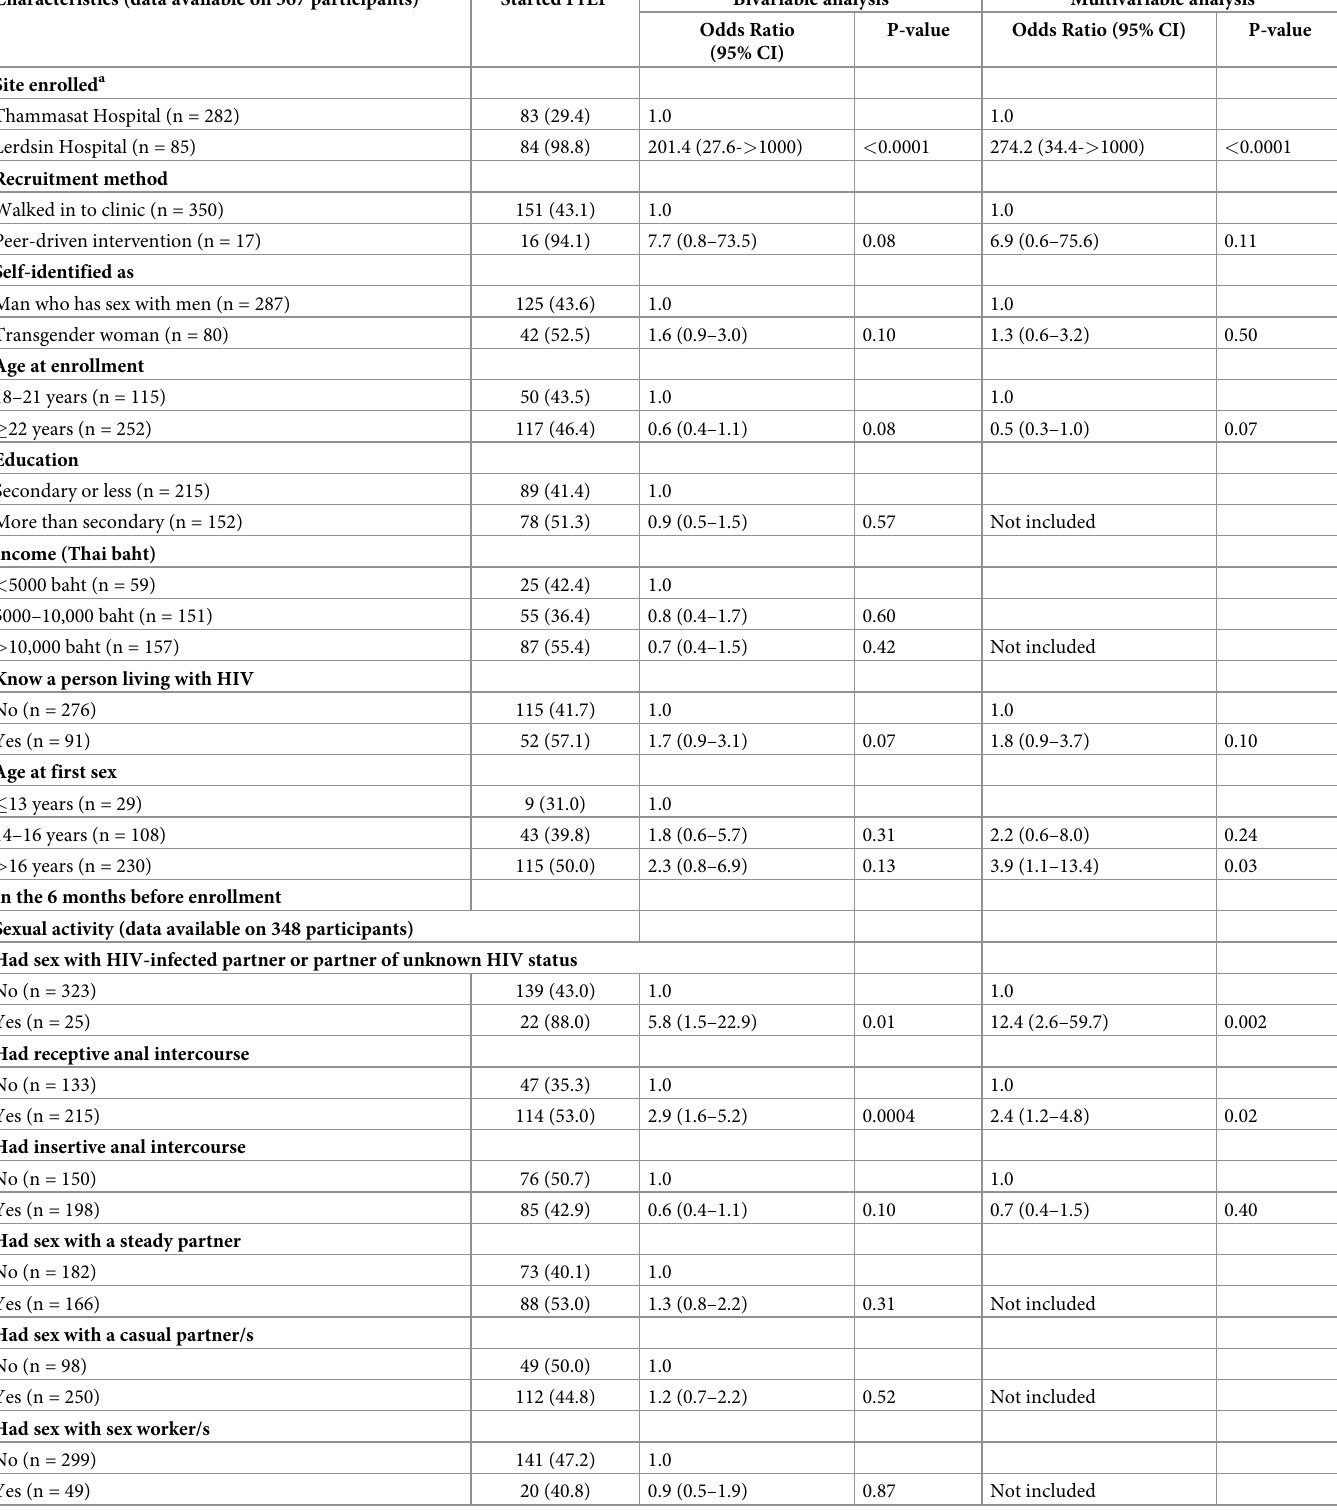
Table 5. Results of logistic regression analysis evaluating characteristics of HIV-uninfected participants in the test, treat, and prevent HIV program at Lerdsin and Thammasat University Hospitals who chose to start HIV pre-exposure prophylaxis (PrEP), Thailand, 2015–2016. Characteristics (data available on 367